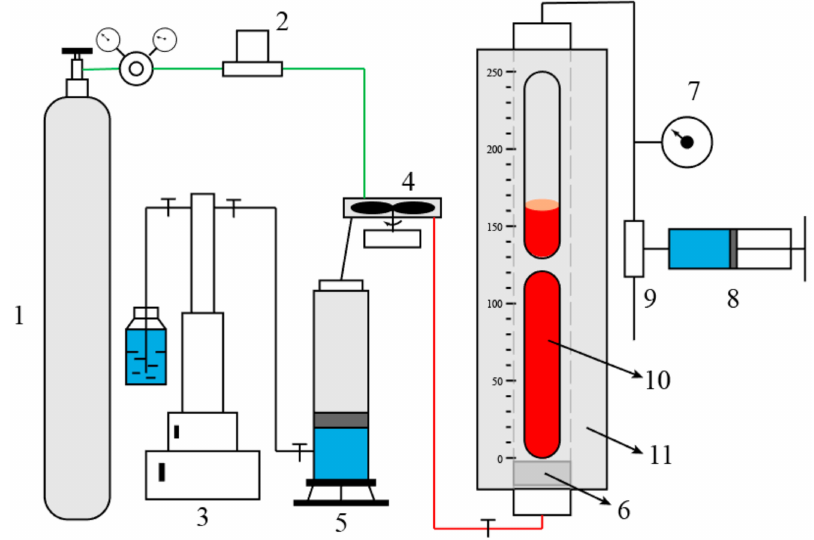
Figure 1. Foam performance evaluation